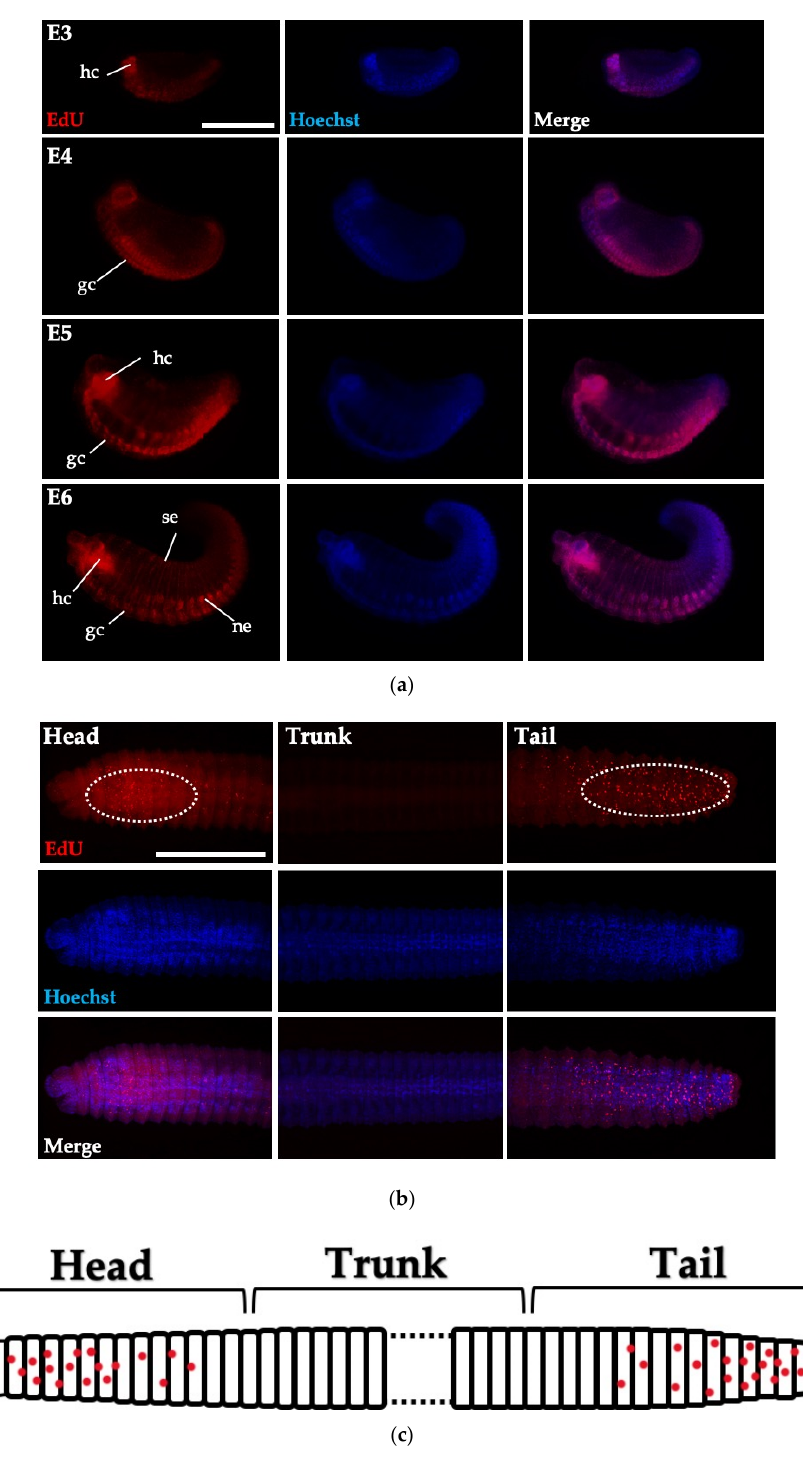
Figure 4. The pattern of cell proliferation in embryo and juvenile of P. excavatus. ( a ) Proliferating cells are visualized using the EdU assay (red) and Hoechst stained DNA (blue) during embryogenesis. Abbreviations: gc, ganglionic cell; hc, hypocerebral ganglionic cell; ne, nephridium; se, segment. Scale bar, 200 µ m. ( b ) Cell proliferation in the head, trunk, or tail of juvenile of P. excavatus is visualized using EdU assay. Scale bar, 500 µ m. ( c ) The schematic cartoon shows red spots representing cell proliferation in the juvenile. The head and tail part of the juvenile shows EdU-positive proliferating cells, whereas EdU-positive cells in the trunk are not detectable ( b , c ). Scale bar, 200 µ